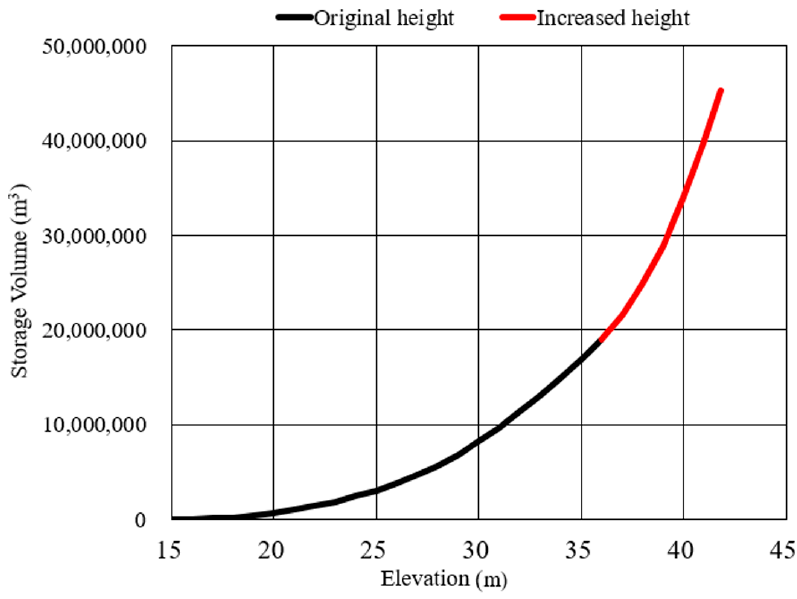
Figure 6. Storage volume according to dam elevation.